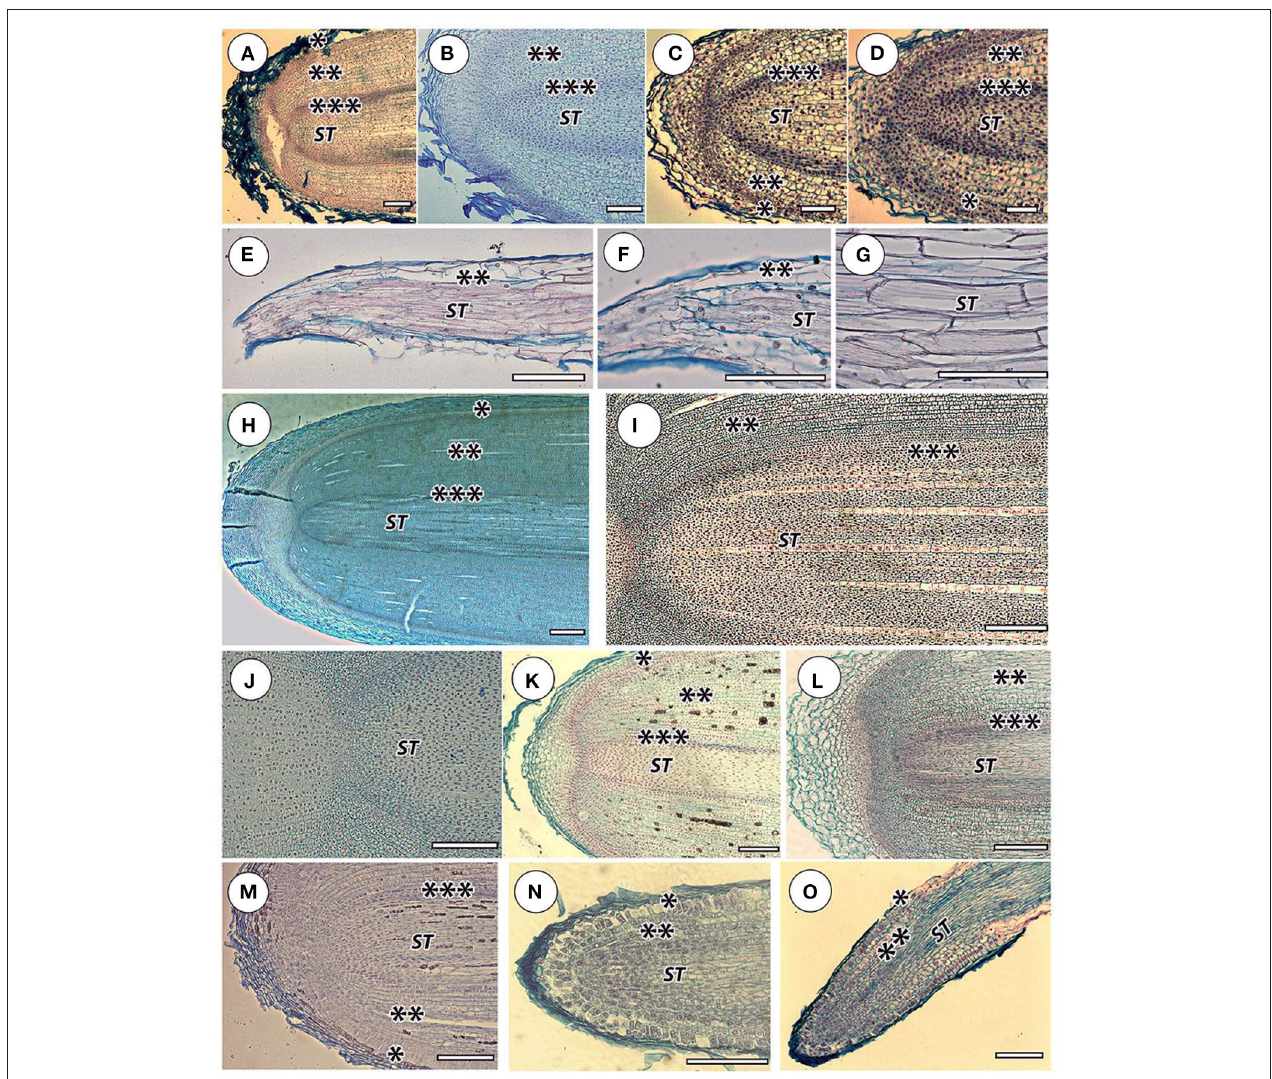
FIGURE 2 | Apical zones in selected species. Orchidaceae: (A) Cattleya skinneri , (B) Neofinetia falcata, (C) Cymbidium finlaysonianum, (D) Grammatophyllum speciosum ; Stanhopea tigrine . Lateral root catchers: (E) general root view, longitudinal section, (F) apical root part, clear that the meristem is absent, (G) stele cells in the middle root part, it is clear that the walls are fibrous and thickened. Araceae: (H) Monstera deliciosa —general view of the thick root apical meristem, (I) M. deliciosa —general view of the thin root apical meristem, (J) M. deliciosa— central meristem part, (K) Anthurium crassinervium . Bromeliaceae: (L) Tillandsia ionantha . Moraceae: (M) Ficus formosana . Cactaceae: (N) Rhipsalis mesembryanthemoides —apical part, (O) Rhipsalis mesembryanthemoides— elongation zone, general view. Sliced tissue: (*) protoderm and/or rhizoderm (in orchid velamen); (**) cortex; (***) pericycle; (ST) stele. Scale 100 µ m; except (H)- − 1,000 µ